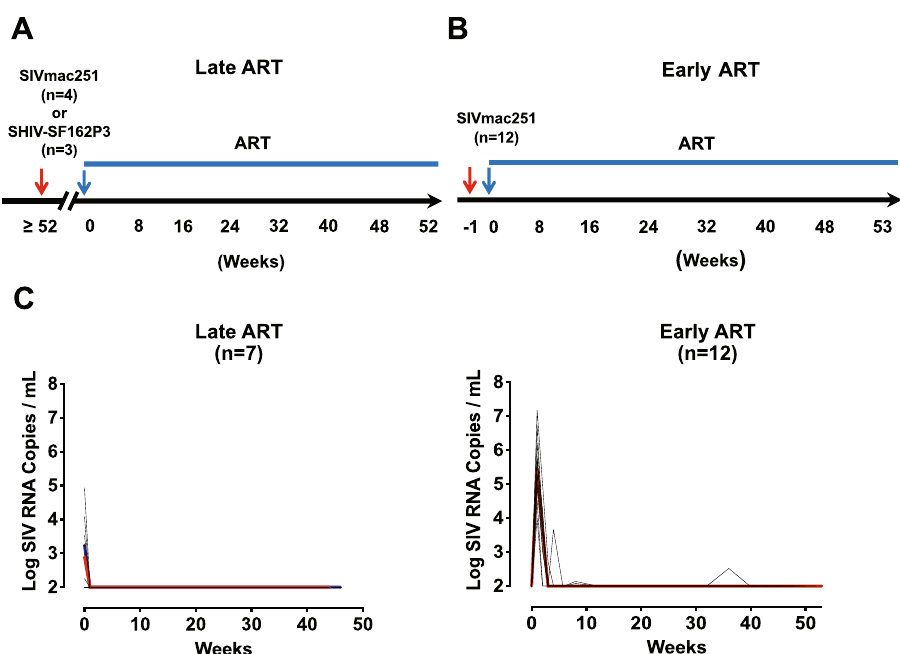
Fig. 1 Experimental design of Late and Early ART-suppressed SIV or SHIV-infected cohorts. A Late ART study design: 7 rhesus monkeys were infected with either SIVmac251 or SHIV-SF162P3 ( n = 4 and 3 animals/group, respectively) for at least a year ( ≥ 52 weeks). ART was initiated at week 0 and daily ART administration was maintained until the day of necropsy. B Early ART study design: 12 rhesus monkeys were infected with SIVmac251 for 1 week. Animals were maintained on daily ART suppression until the day of necropsy. C Plasma viral loads are shown for the Late ART (median line for SIVmac251 infected animals in red and median line for SHIV- SF162P3 infected animals in blue) and Early ART studies. Log SIV-RNA copies/ml are shown (LOD = 50 RNA copies/ml). Black lines indicate individual monkey values. ART, antiretroviral